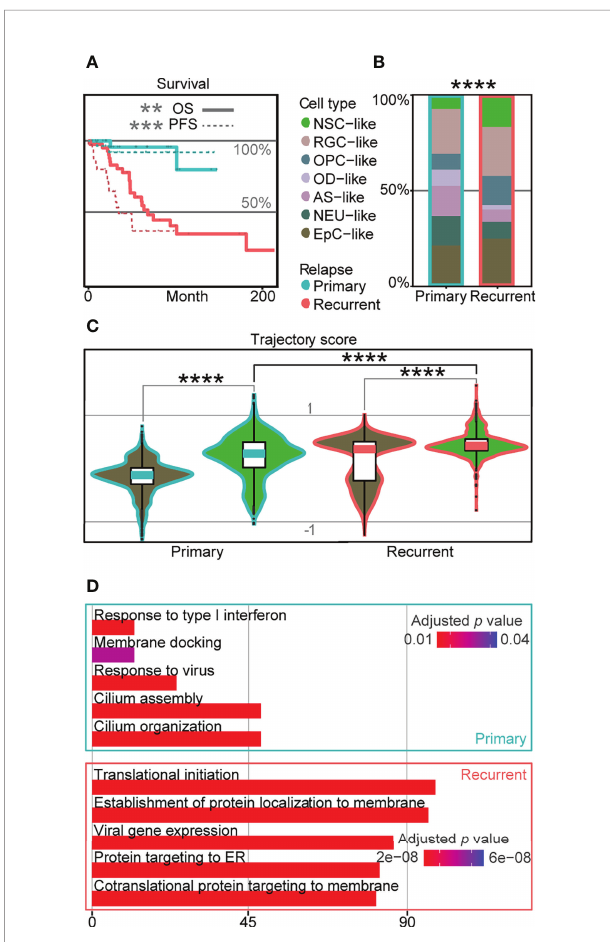
FIGURE 4 | Cellular populations in recurrent EPN with poor prognosis are associated with higher trajectory score. (A) Survival plot of primary and recurrent EPN patients. The solid line refers to overall survival (OS; p -value = 0.0018), and the dotted line refers to progression-free survival (PFS; p = 0.00026), which are colored by relapse situations on published scRNA-seq data (5, 6). (B) Histogram of cell types in primary and recurrent EPN colored by cell types and outlined by primary/recurrent conditions showing signi fi cant difference ( p < 2.2e − 16) between cell types using asymptotic two-sample Fisher – Pitman permutation test. (C) Trajectory score analysis comparison between primary and recurrent samples in NSC- and EpC-like cells using Kruskal – Wallis test (all p < 0.0001). (D) Gene ontology analysis of differentially expressed genes in NSC-like cells between primary and relapse conditions. The "*" means signi fi cant difference (p-value): * p < 0.05; ** P < 0.01; *** p < 0.001; **** p <